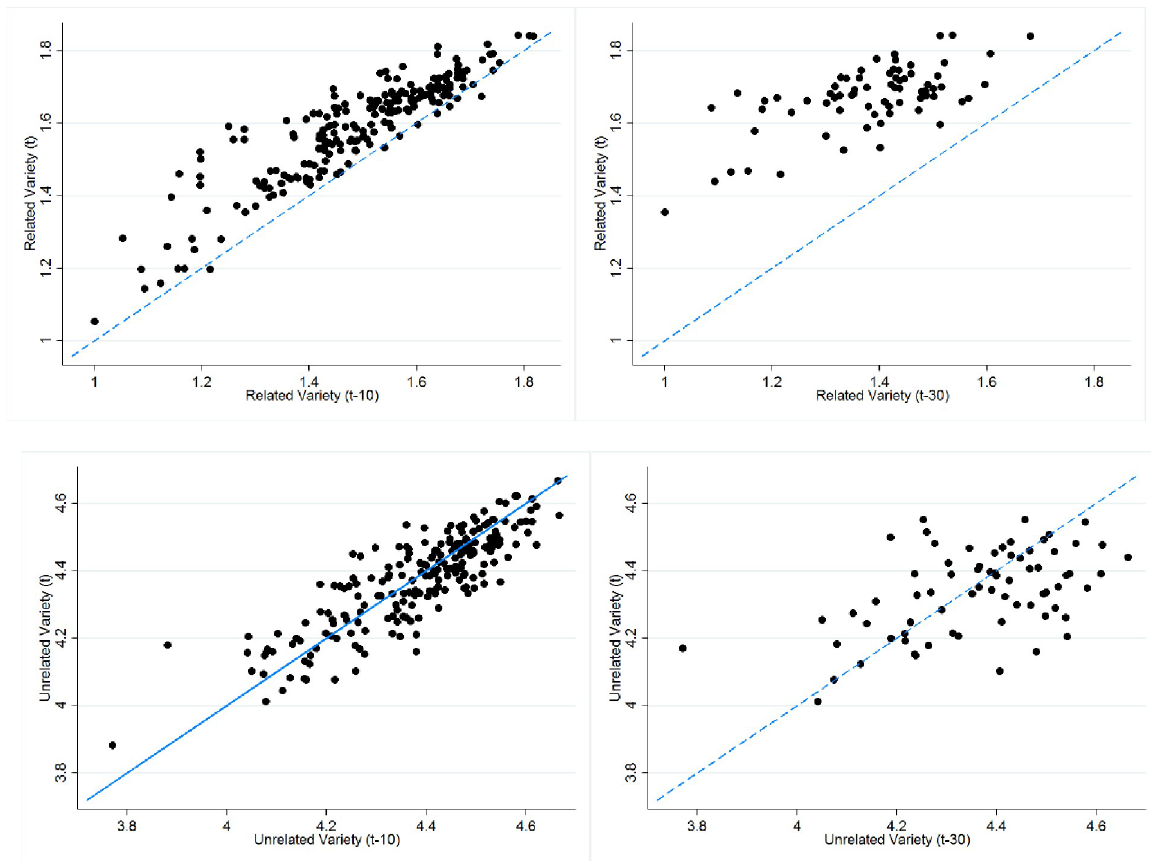
Fig 4. Relationship between related variety in period t and t-10 (on the left) and t and t-30 (on the right). Source: